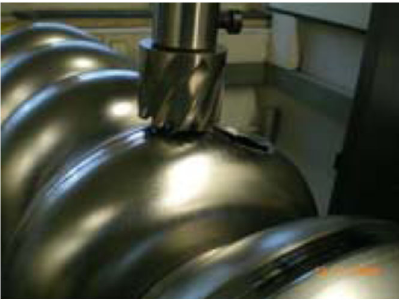
FIG. 2. Separation of samples for